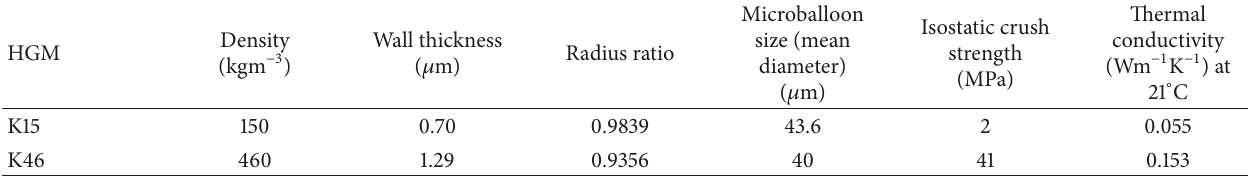
Table 1: Characteristics of hollow glass microballoons